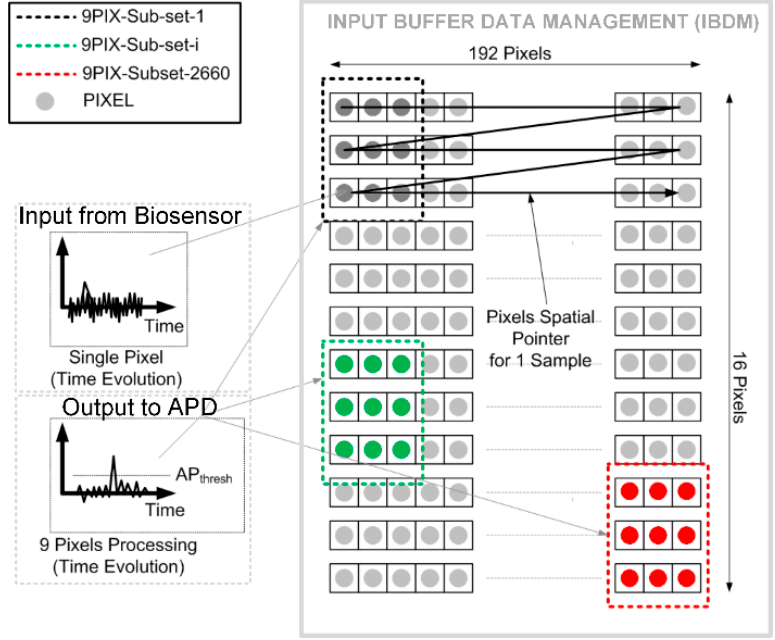
Figure 5. Input buffer data management functional scheme .